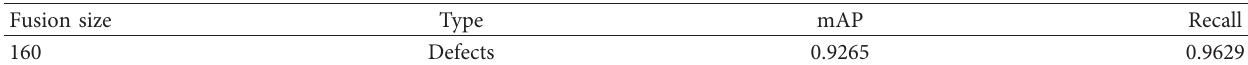
Figure 10: The P-R curve with different fusion sizes. Table 3: mAP and recall of defect